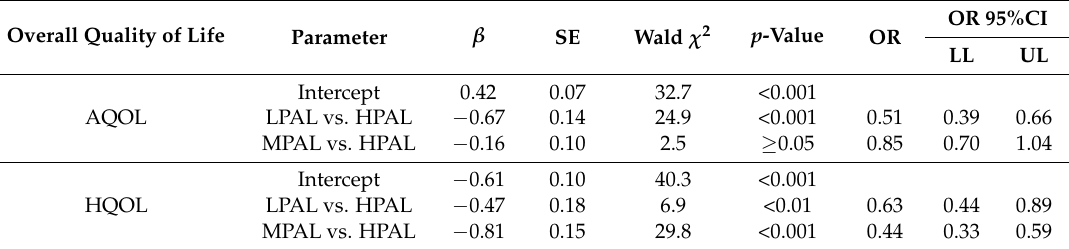
Table 5. Multinomial logistic regression analysis parameters of the dependent variable: overall quality of life in studied